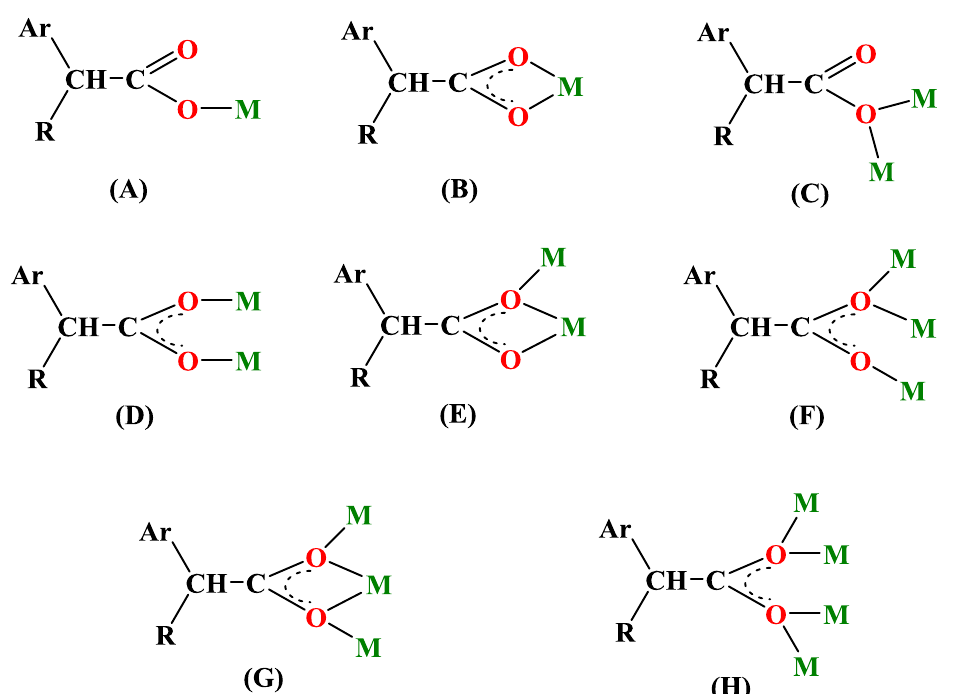
Figure 14. General coordination modes of the carboxylato ligands. (Ar = naphthalene or pyrene ring,